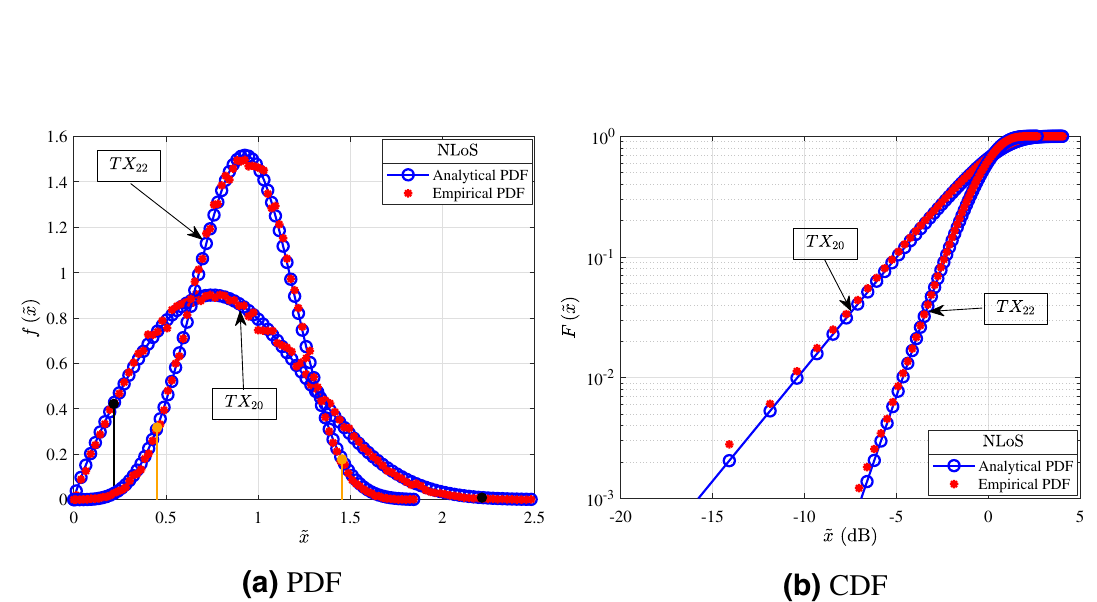
Figure 4. Fitting of PDF and CDF analytical expressions to the empirical channel gain data of the NLoS links (20 and 22) for the shopping mall